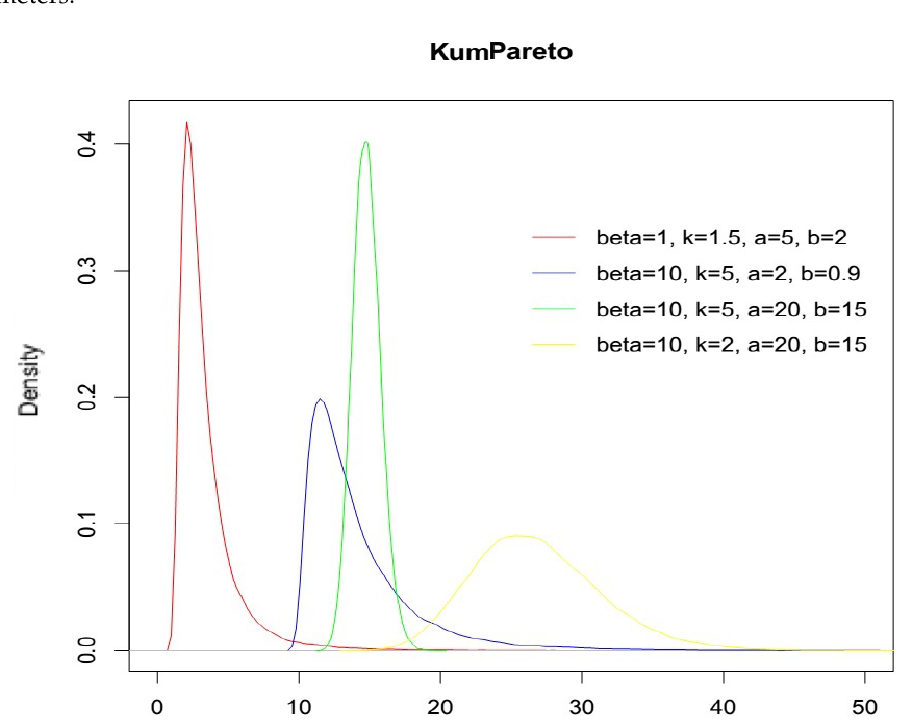
Figure 2. KumPareto density functions.